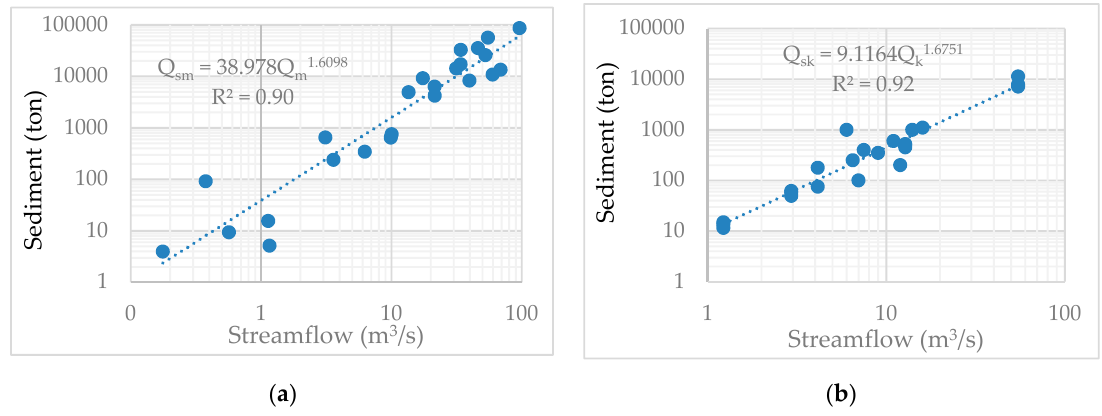
Figure 2. Scattered plot of sediment load vs. streamflow for ( a ) Meki River and ( b ) Ketar River.